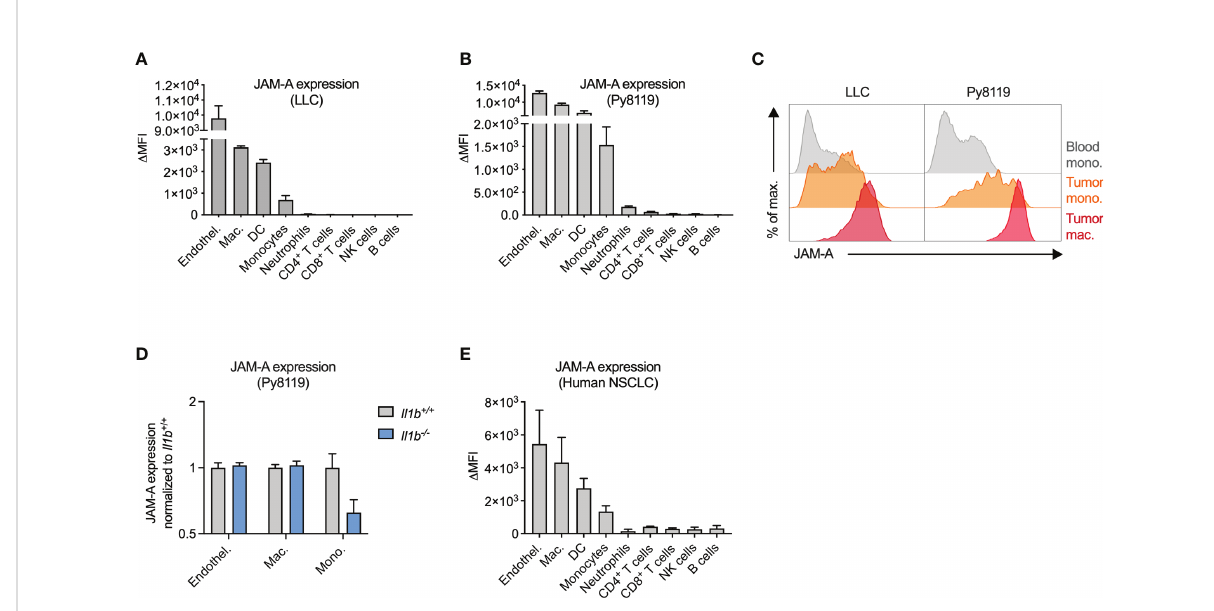
FIGURE 2 JAM-A is expressed on mononuclear phagocytes in fi ltrating human and mouse tumors. (A) JAM-A expression on endothelial cells and immune cells in LLC tumors (n=4-5). 21 days post-engraftment, 1678 ± 212mm 3 tumor volume. (B) Same as (A) in Py8119 tumors (n=4-6). 32 days post-engraftment, 1199 ± 114mm 3 tumor volume. (C) Representative histogram of JAM-A expression on blood monocytes, tumor-in fi ltrating monocytes and tumor-associated macrophages in LLC and Py8119 tumors. (D) Fold change of JAM-A expression on macrophages, monocytes and endothelial cells in Py8119 tumors of Il1b -/- mice compared to Il1b +/+ mice (n=6). 35 days post-engraftment, tumor burden is shown in Supplementary Figure 3. (E) JAM-A expression on endothelial cells and immune cells in human non-small cell lung cancer (NSCLC) (n=3). JAM-A expression was determined using fl ow cytometry. D